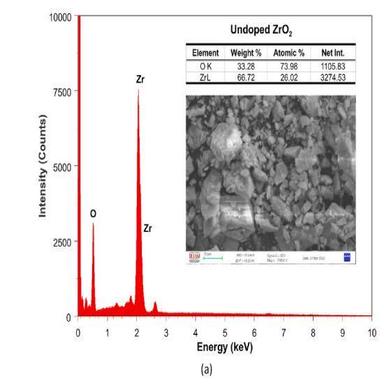
EDS spectra with elemental composition of (a) ZrO2 (b) ZrO2:Dy3+ (c) ZrO2:Dy3+,K+.